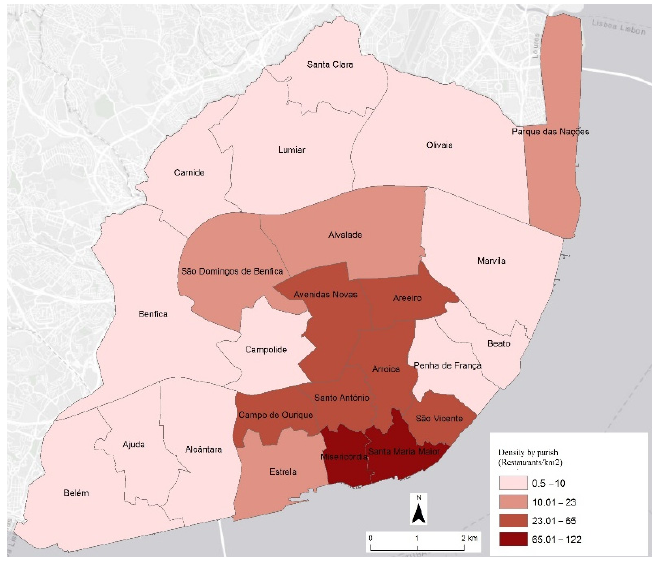
Figure 1. TripAdvisor’s coverage of the restaurant sector in the city of Lisbon (density by parish, restaurants/km 2 ).